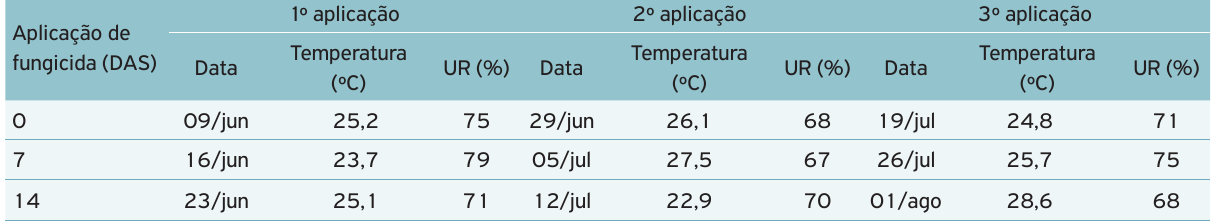
Tabela 1. Datas e condições meteorológicas observadas durante as aplicações de fungicida para os três diferentes momentos de aplicação estudados para o controle da ferrugem da folha do trigo em Londrina, 2010.